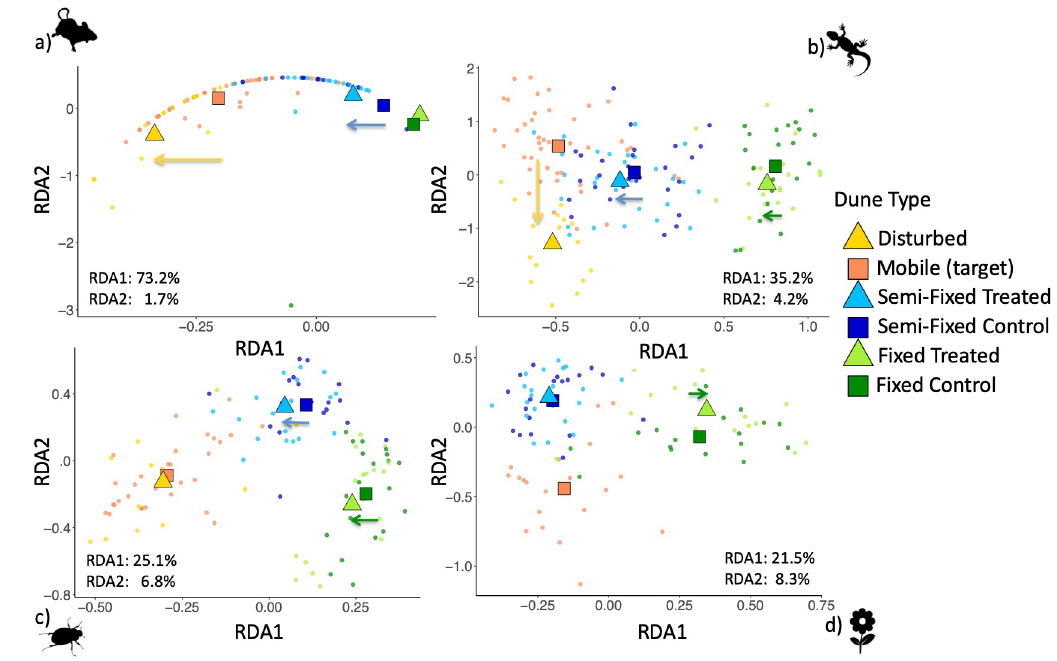
Figure 4. Overall summary of redundancy analysis (RDA) analyses with all dune types included for ( a ) rodents; ( b ) reptiles ( c ) beetles and ( d ) annual plants. Arrows depict direction of treatment e ff ect along RDA1. Significance testing was performed in each dune type separately (see Figures 5–7).